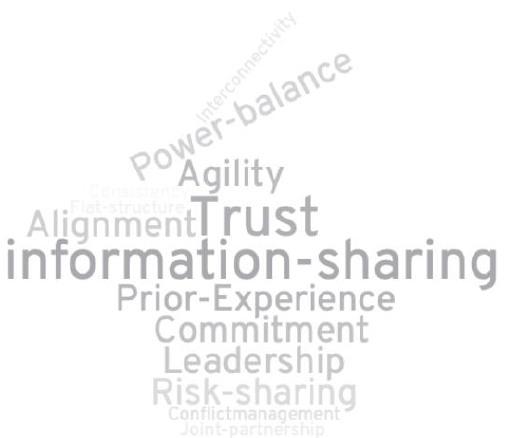
Figure 2. The emergence of the words appeared in thematic analysis of the literature.